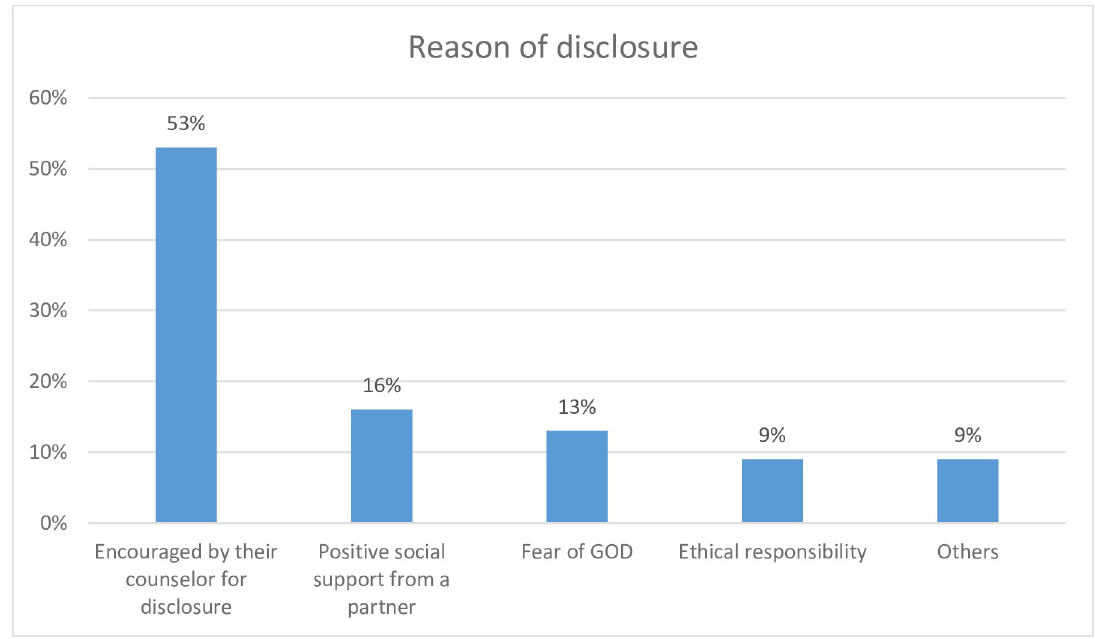
Fig 1. Participants’ reasons for disclosure of their HIV-positive status to a